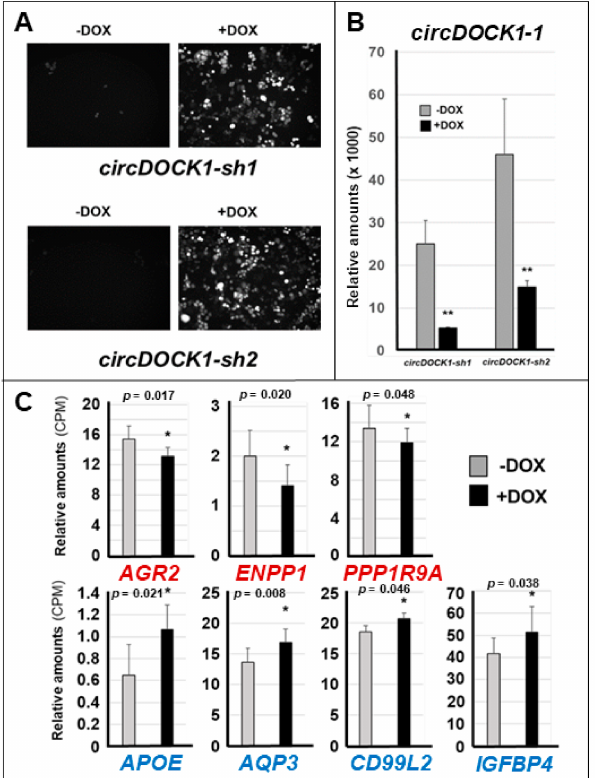
Figure 6. Effects of circDOCK1-1 silencing in CAMA-1 cells on the expression of genes whose expression is modulated by circDOCK1-1 overexpression. Luminal CAMA-1 cells were infected with a retroviral construct, which allows doxycyclin (DOX)-dependent silencing of circDOCK1-1 . Following infection, two independent cell populations ( circDOCK1-sh1 and circ-DOCK1-sh2 ) were isolated. ( A ) The figures show that the two cell populations express significant levels of the circDOCK1-1 targeting constructs only following exposure to DOX, as indicated by the positivity of cells to the Red Fluorescent Protein. ( B ) The column diagram shows the level of circDOCK1-1 expression as determined by RT-PCR analysis with a specific Taqman assay. ** Significantly lower than the corresponding vehicle-treated ( − DOX) sample ( p < 0.01 following Student’s t -test). No significant difference was observed between the − DOX circDOCK1-sh1 and circ-DOCK1-sh2 groups. ( C ) The column graphs shows: (1) the levels of the indicated mRNAs that are significantly upregulated by circDOCK1-1 overexpression in both MDA-MB-231 and MDA-MB-157 cells and are marked in red ( AGR2 , MPP1 , and PPP1R9A ); (2) the levels of the indicated mRNAs that are significantly downregulated by circDOCK1-1 overexpression in both MDA-MB-231 and MDA-MB-157 cells and are marked in blue ( APOE , AQP3 , CD99L2 , and IGFBP4 ). The results were obtained using RNA-seq following isolation of total RNA from triplicate cultures of the two cell populations exposed to vehicle or DOX and are expressed in CPM (counts per million reads). * Significantly different. The p -values of the − DOX vs. +DOX comparisons (Student’s t -test; N = 6) are